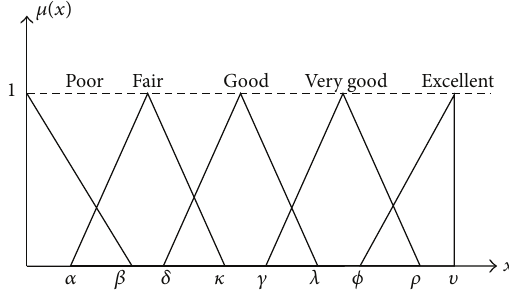
Figure 4: Triangular fuzzy numbers